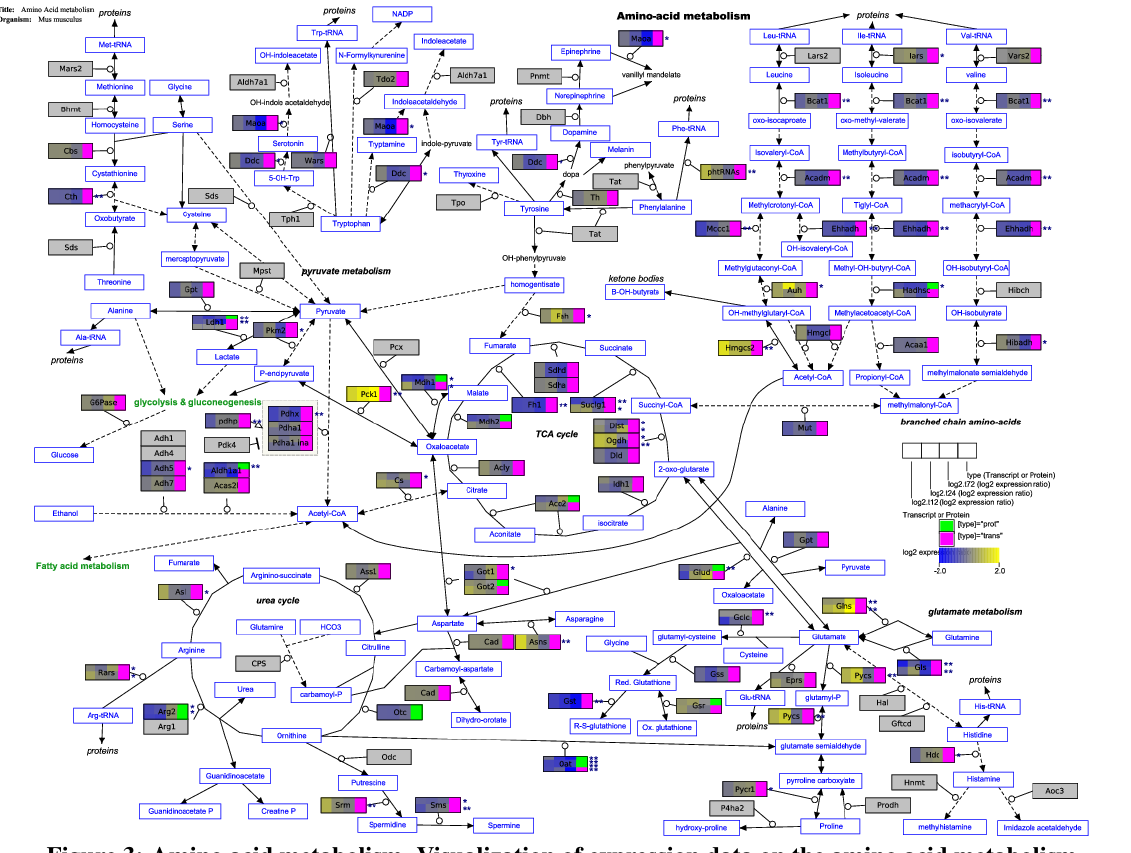
Figure 3: Amino acid metabolism. Visualization of expression data on the amino acid metabolism pathway. Coloring is identical to Figure 2. The genes Otc2 , Arg2 and Oat , mentioned in the main text, can be found in the bottom-left quadrant of the image. Gls , Glns and Pycs can be found in the bottom-right